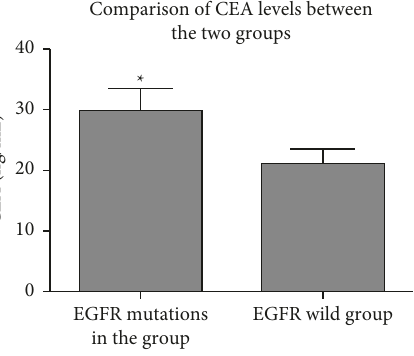
Figure 1: Comparison of CEA levels in two groups.